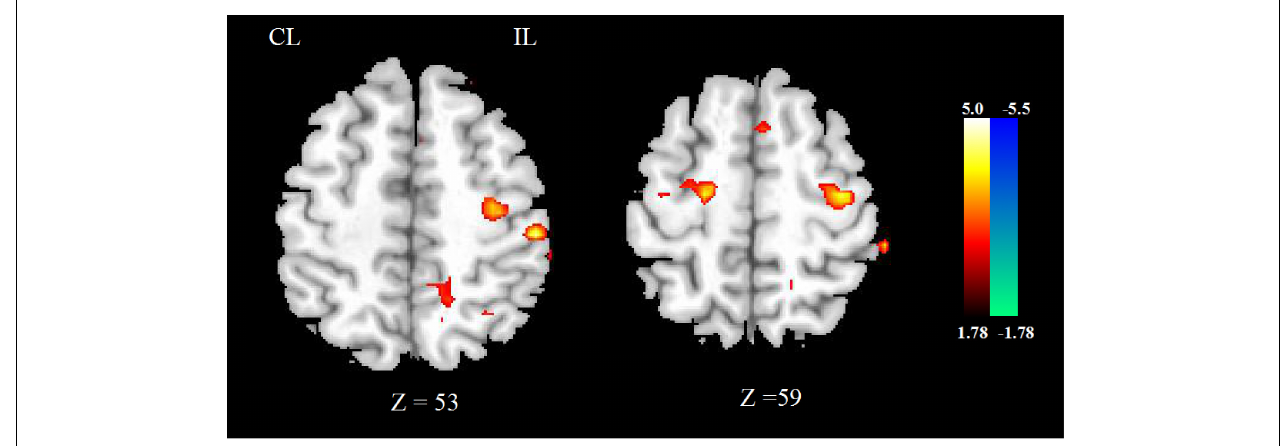
FIGURE 5 | The FA changes between real and sham rTMS